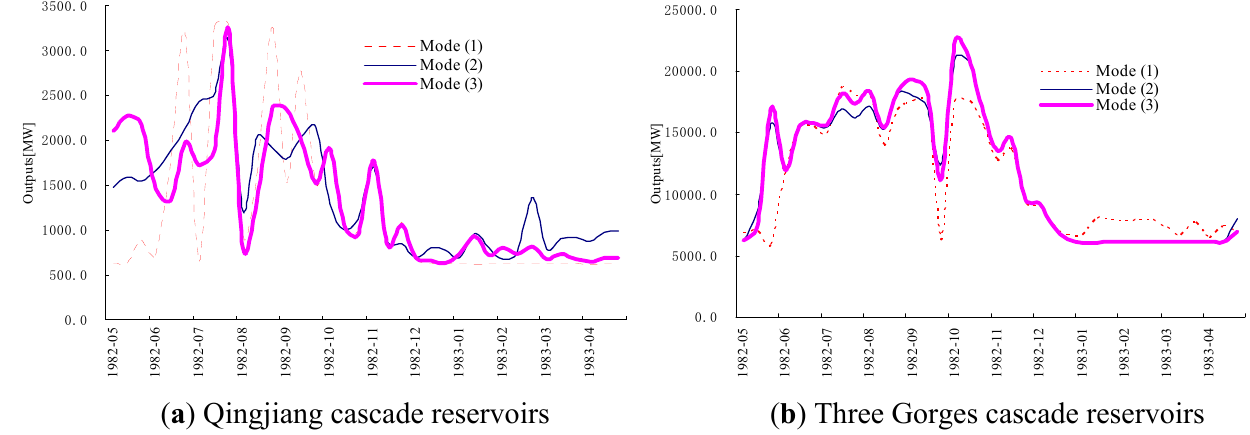
Figure 5. Comparison of the outputs for three operation modes (wet year).